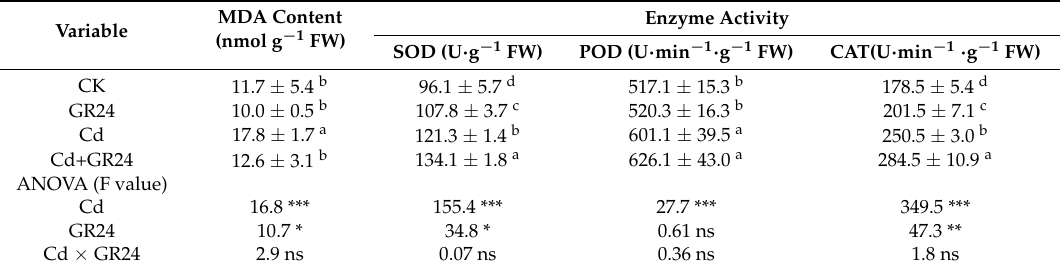
Table 3. Lipid peroxidation and antioxidant enzyme activity treated with Cd and GR24.